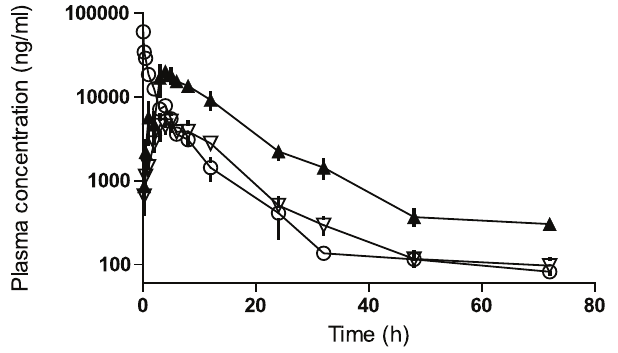
Figure 4. Pharmacokinetics of hAd in Sprague Dawley rats. At t=0 hAd was dosed i.v. at 4.1 mg/kg (open circles), i.p. at 4.1 mg/kg (open triangles) or i.p. at 13.4 mg/kg (closed triangles). n=2–5.